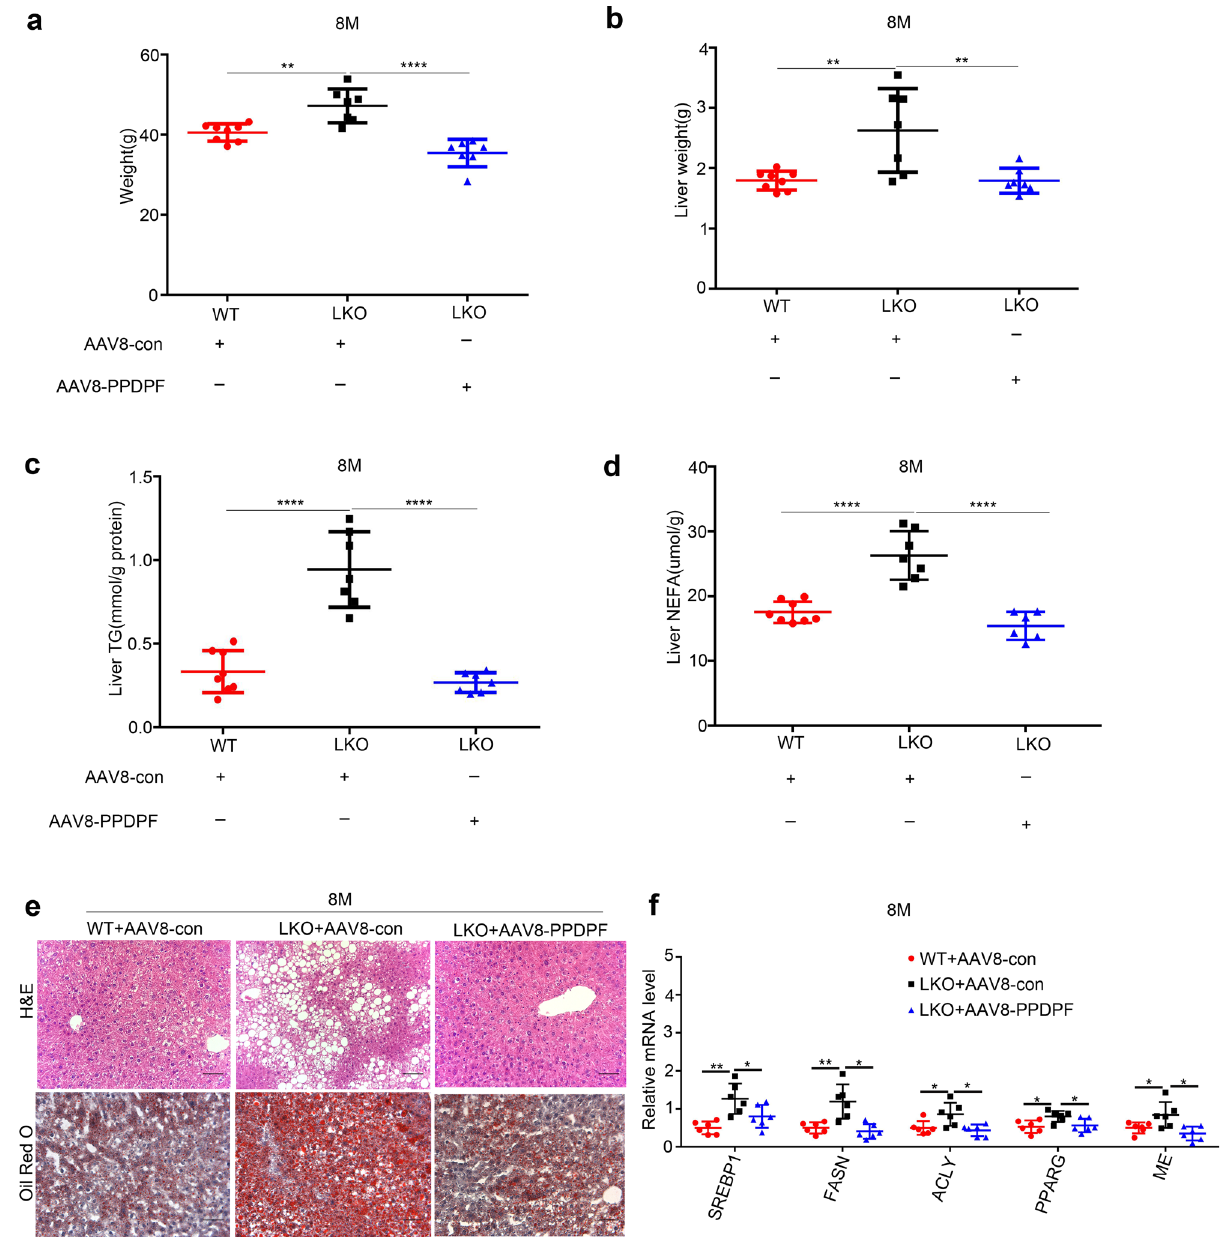
Fig. 3 AAV8-mediated reintroduction of PPDPF rescues the phenotype of PPDPF-null in PPDPF-LKO mice fed a chow diet for 8 months. The body weight ( a ), liver weight ( b ), TG test ( c ) and NEFA test ( d ) of WT + AAV8-con ( n = 8), LKO + AAV8-con ( n = 7), and LKO + AAV8-PPDPF ( n = 7) mice at 8 months on chow diets. Mean ± SEM, ( a ) ** p = 0.0017 (WT + AAV8-con Vs LKO + AAV8-con), **** p < 0.0001 (LKO + AAV8-con Vs LKO + AAV8- PPDPF), ( b ) ** p = 0.0055 (WT + AAV8-con Vs LKO + AAV8-con), ** p = 0.01 (LKO + AAV8-con Vs LKO + AAV8-PPDPF), ( c ) **** p < 0.0001 (WT + AAV8-con Vs LKO + AAV8-con), **** p < 0.0001 (LKO + AAV8-con Vs LKO + AAV8-PPDPF), ( d ) **** p < 0.0001 (WT + AAV8-con Vs LKO + AAV8- con), **** p < 0.0001 (LKO + AAV8-con Vs LKO + AAV8-PPDPF) by two-tailed unpaired Student ’ s t test. e Representative images of H&E and Oil Red O s t aining of liver sections from the mice injected with indicated adenovirus at 8 months. Scale bars, 100 um. f The mRNA expression levels of lipogenesis-related genes in WT + AAV8-con ( n = 6), LKO + AAV8-con ( n = 6) and LKO + AAV8-PPDPF ( n = 6) mice at 8months. Mean± SEM, SREBP1 : ** p = 0.0015, * p = 0.0463; FASN : ** p = 0.0050, * p = 0.0029; ACLY : * p = 0.0322, * p = 0.0123; PPARG : * p = 0.0134, * p = 0.0281; ME : * p = 0.459, * p = 0.011 by two-tailed unpaired Student ’ s t test. All ex p eriments were repeated three times